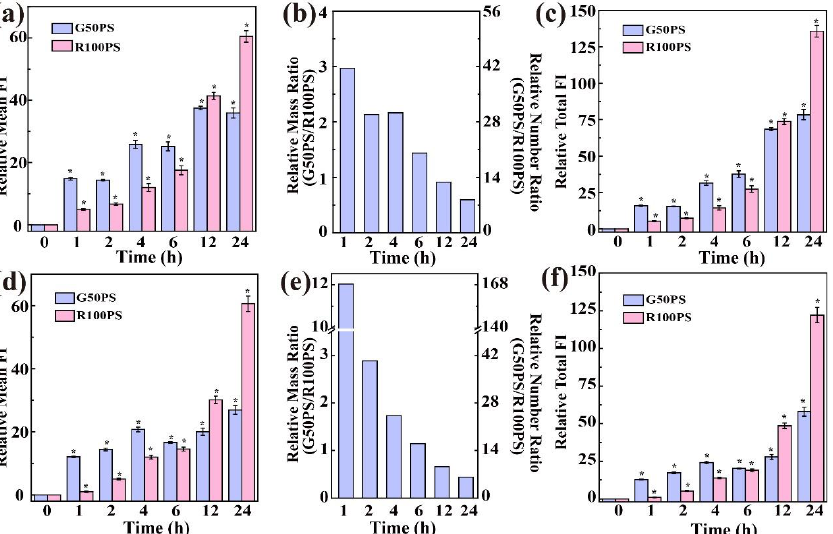
Figure 3. Cellular uptake of PS NPs after cells were exposed to PS NPs (20 μg/mL) for different times. The uptake is represented as the relative content of PS NPs in cells ( a and d ), the relative mass (left y-axis)/number (right y-axis) ratio (G50PS/R100PS) of PS NPs in cells ( b and e ), and the relative total content of intracellular PS NPs calculated by multiplying relative mean FI with cell number ( c and f ). ( a - c ) A549 cells. (d-f) BEAS-2B cells. The content of R100PS in BEAS-2B cells incubated with 20 μg/mL R100PS for 1 h was set as 1 ( a and d ). *P < 0.05 compared with the control (n=3).